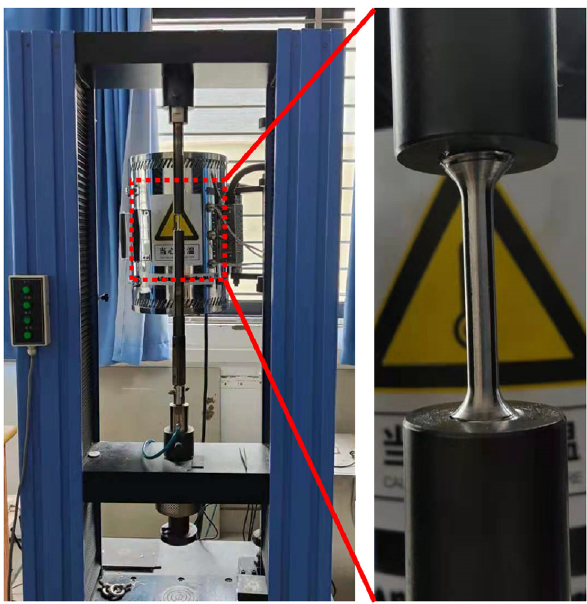
Figure 6: The true stress – strain curves of Ti – 3Al – 2Mo – 2Zr alloy under di ff erent strain rates.